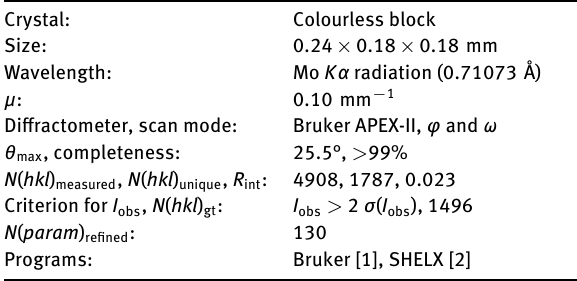
Table 2: Fractional atomic coordinates and isotropic or